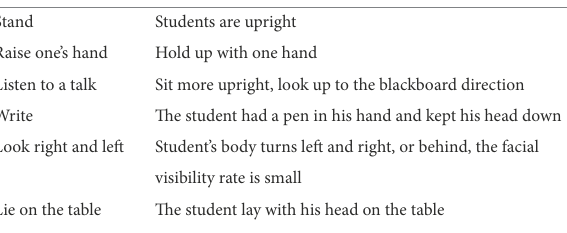
TABLE 8 Discrimination of students’ behaviors in English learning classroom.